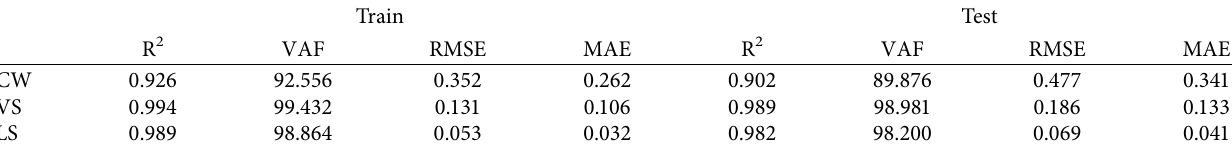
Table 8: Performance indicator values for building MFO models for outputs (CW, VS, and